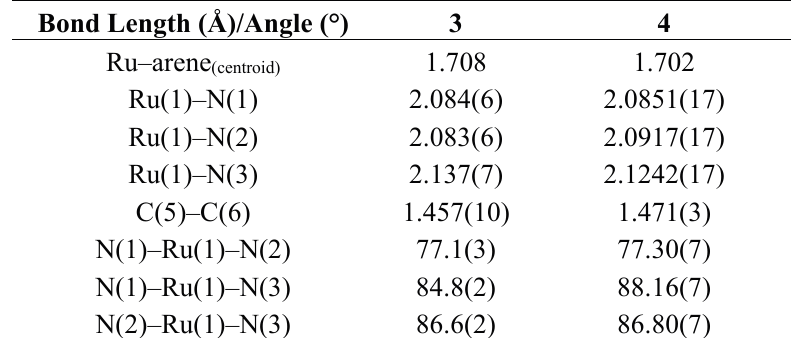
Table 2. Selected bond distances (Å) and angles (°) for 3 and 4 . In the case of 3 the mean values of the four independent structures present in the unit cell are reported, the data for all the structures are reported in the Supporting